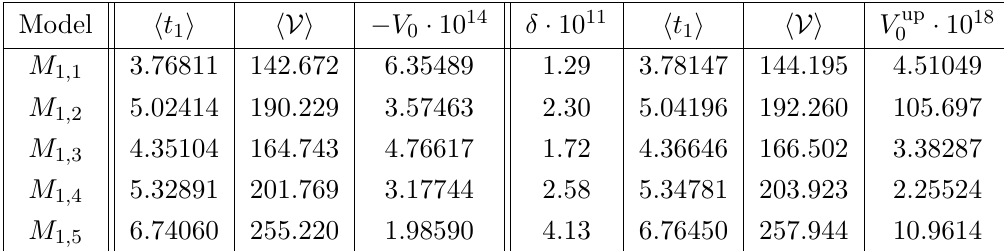
= 1 . The underlying + = − 10 − 4 , a = 0 . 1 , g = 0 . 1 , K = 0 . 1 , A = 1 and the axion ρ 0 1 s cs 1 = 0 . 1 i